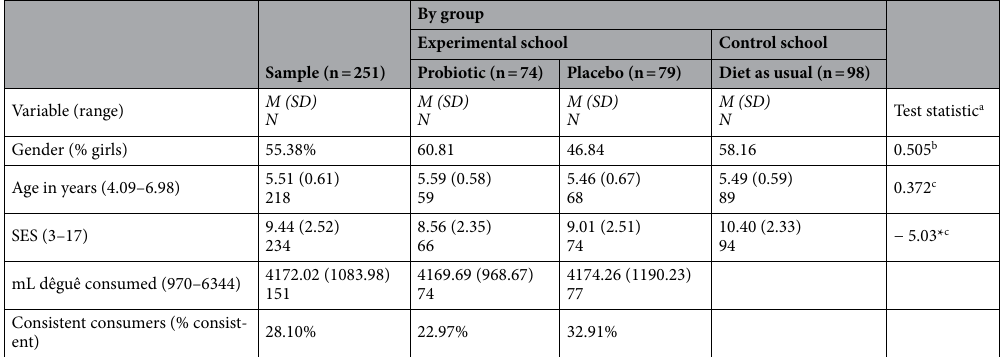
Table 1. Sample demographics and school comparison. M Mean, SD Standard deviation. a Test statistics are for differences between the experimental school and control school. b χ 2 tests for categorical data. c Independent samples t-tests for normally distributed data. SES Socioeconomic status, mL Milliliters. *p < 0.001.